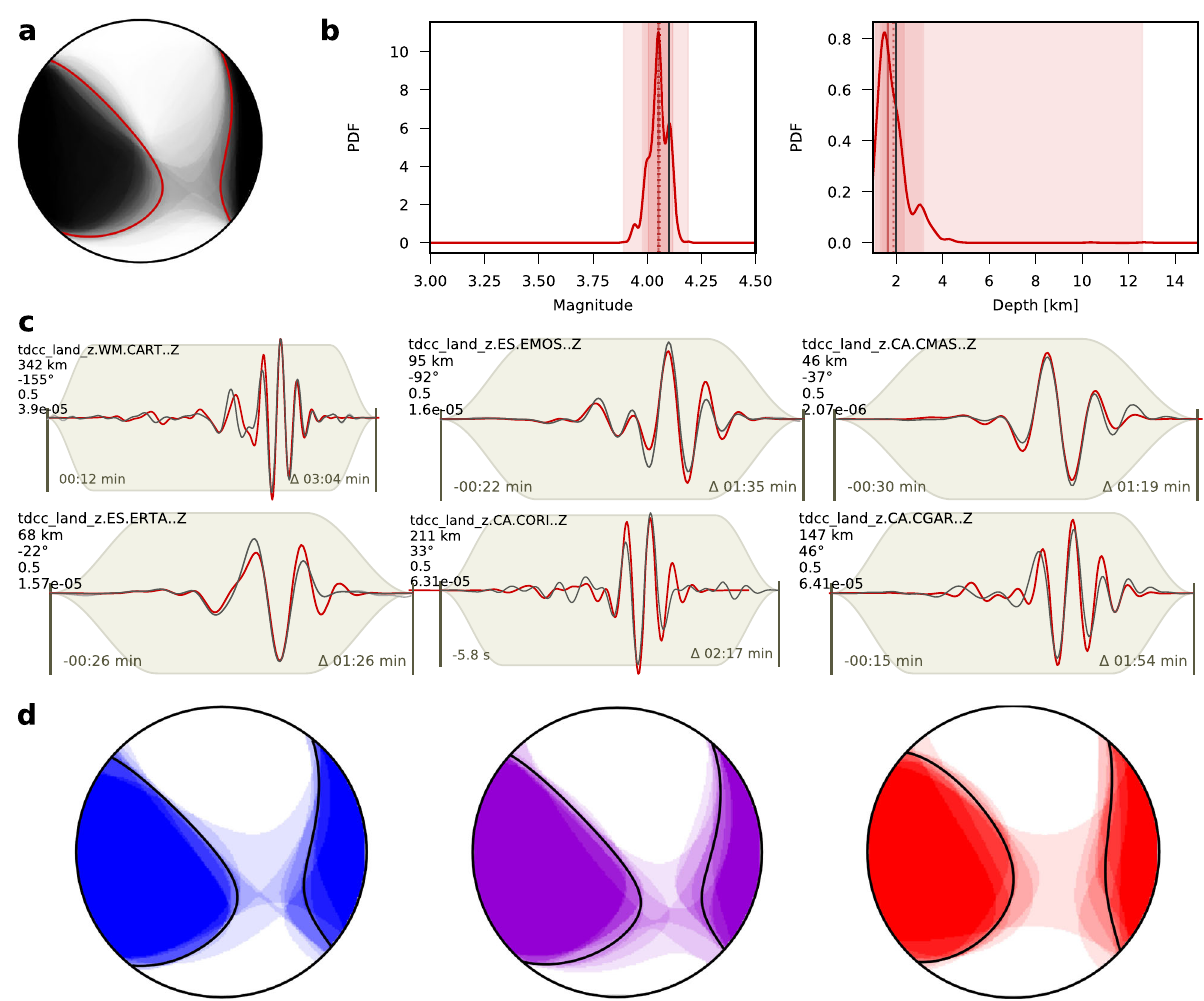
Fig. 3 Overview of the moment tensor inversion results. a Overlay of deviatoric moment tensor solutions obtained for the October 2, 2013, 23:06 UTC earthquake (Supplementary Table 2) out of the bootstrap approach (gray focal spheres) and best solution using all data (red thick line focal sphere). b Probability density functions for moment magnitude (Mw) and depth for the same event (red dotted and solid line indicate best and mean solutions, dark to light red background con fi dence levels of 68, 90, and 95%). c Examples of waveform fi t (red and black lines denote synthetic and observed displacement waveforms, respectively) at selected stations for the same event (station name, azimuth, distance, weight, and maximal displacement are reported). d Overlay of moment tensor solutions for 9 studied events (quality A and B, Mw 3.4 – 4.1), assuming three different velocity models: model I (blue), G (purple), and V (red focal sphere); thick black lines denote the focal sphere of the cumulative moment